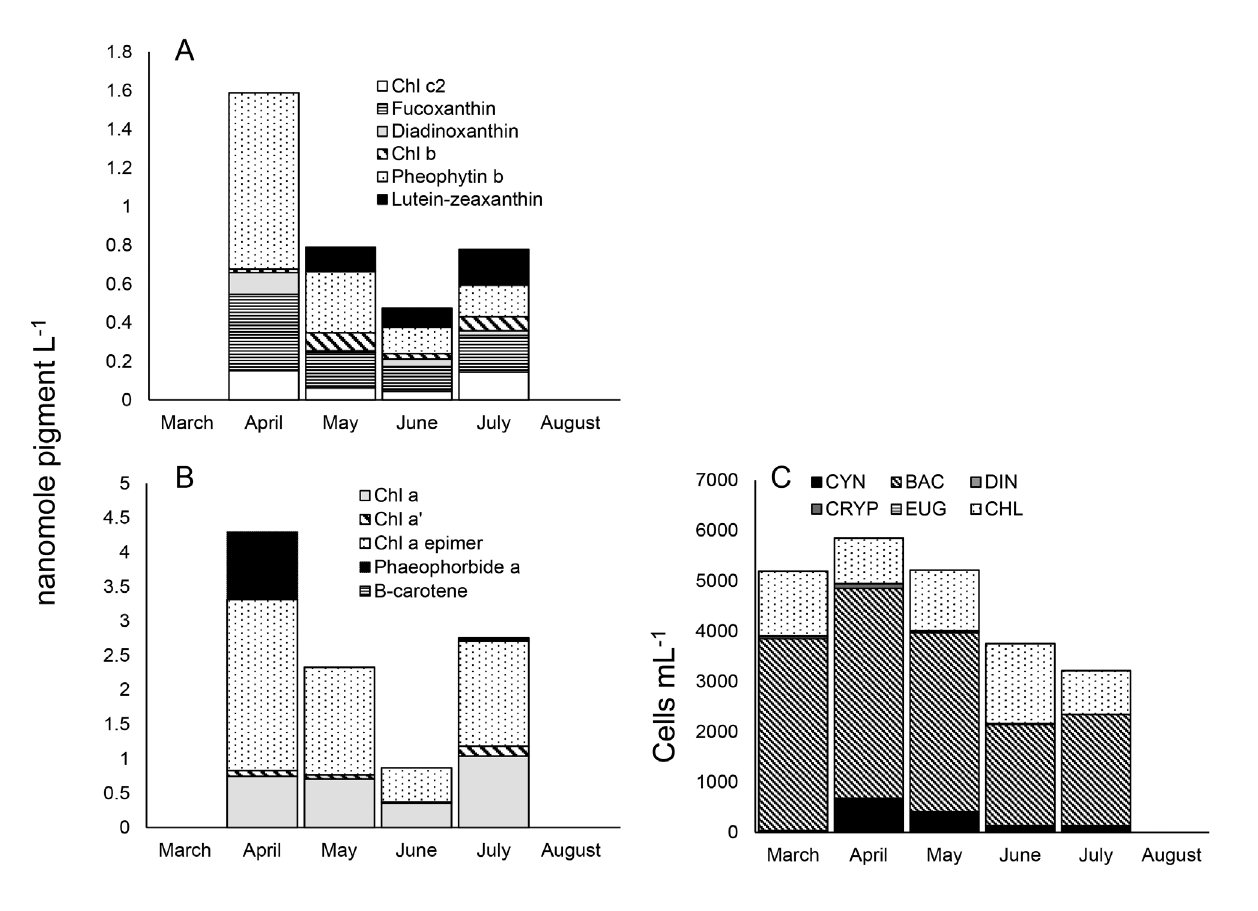
Figure 4 – Phytoplankton enumerations separated into: A, taxonomically diagnostic pigment indicators; B, ubiquitous pigments (Chl a and b-carotene) and a-phorbin degradation products; C, microscopic phytoplankton enumerations grouped by family including cyanobacteria (CYN), Bacillariophyta (BAC), Dinoflagellates (DIN), Cryptophyta (CRYP), Euglenophyta (EUG), Chlorophyta (CHL) monitored across the dry (March–April) and wet (May–July) seasons.